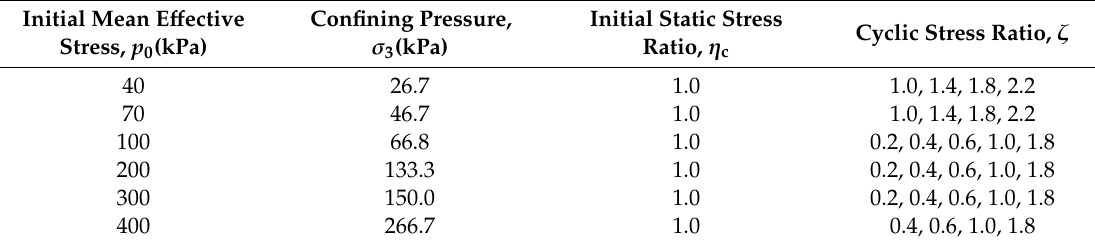
Table 2. Summary of the dynamic test programs.